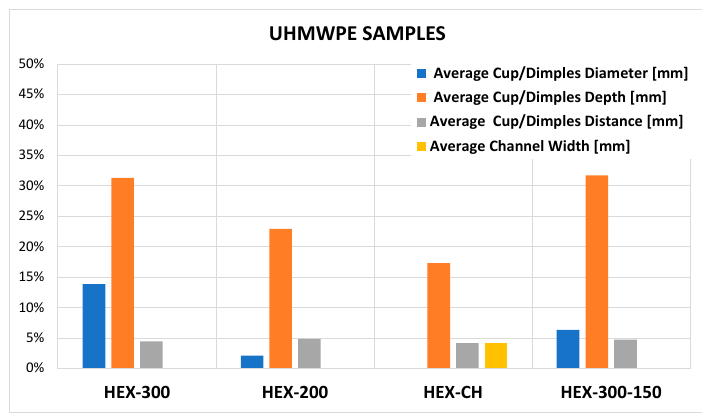
Figure 13. Percentage errors for UHMWPE samples.